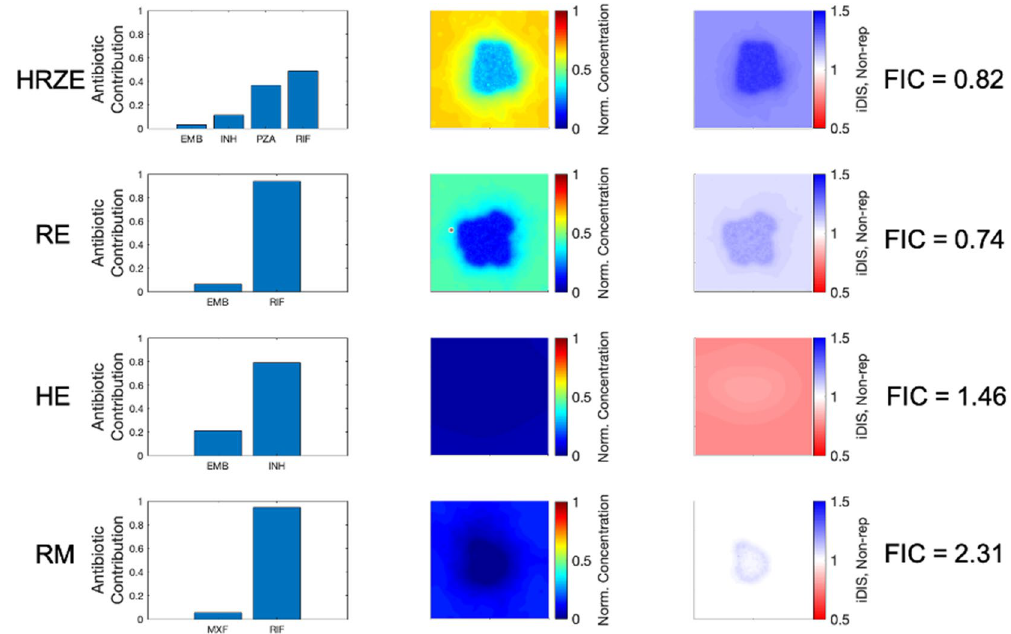
Figure 7. Contribution of individual antibiotics to the in vivo drug interaction score (iDIS). Values of iDIS are associated with the proportion of each antibiotic’s contribution to effective concentration. Four different regimens are shown: HRZE (first row), RE (second row), HE (third row), and RM (fourth row). Bar plots indicate the relative contribution of each antibiotic in the regimen to the effective concentration on average throughout the granuloma. Heat maps for each drug combination show the effective concentration normalized to the C 50 for non-replicating Mtb (second column). The calculated iDIS value for non-replicating Mtb is shown in the fourth column, with the color bar representing the iDIS value: blue represents synergy, white represents additivity, and red represents antagonism. All heat maps reflect conditions 6 h after dosage with each antibiotic in the corresponding regimen. Heat maps and plots were made using MATLAB (R2019a) 45 .